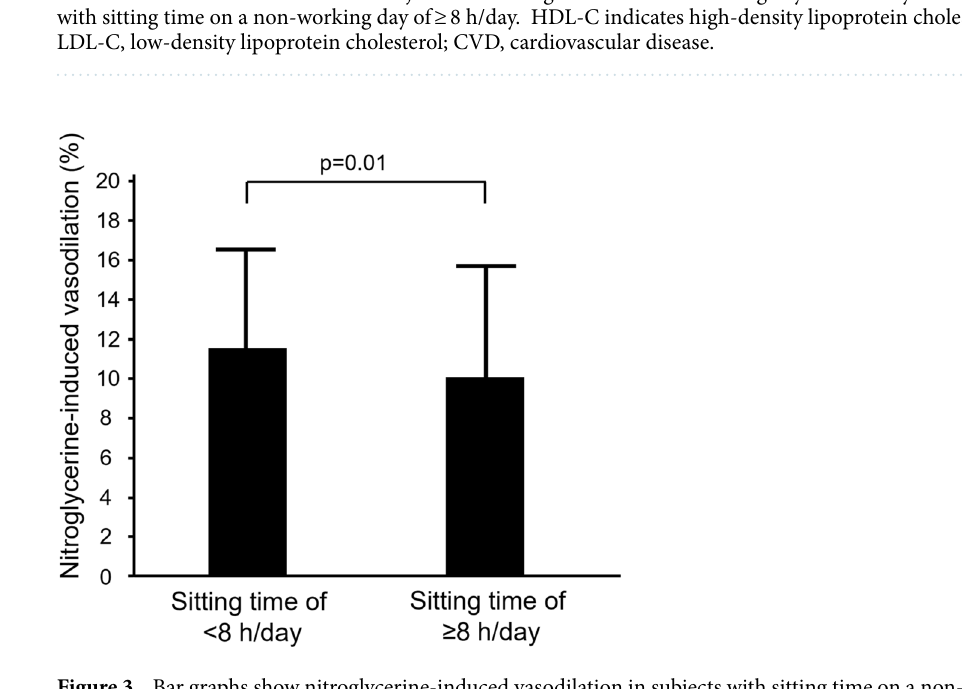
19 pandemic and during the COVID-19 pandemic. The baseline characteristics of the 327 subjects enrolled before the COVID-19 pandemic are summarized in Tables IV and V in the Data Supplement. The baseline characteristics of the 119 subjects enrolled during the COVID-19 pandemic are summarized in Tables VI and VII in the Data Supplement. In subjects enrolled before the COVID-19 pandemic, FMD values were 3.2 ± 2.8% in subjects with sitting time on a non-working day of < 6 h/day and 2.0 ± 2.4% in subjects with sitting time on a non-working day of ≥ 6 h/day ( p < 0.001) (Figure VA in the Data Supplement). NID values were 11.1 ± 4.8% in subjects with sitting time on a non-working day of < 8 h/day and 9.9 ± 5.1% in subjects with sitting time on